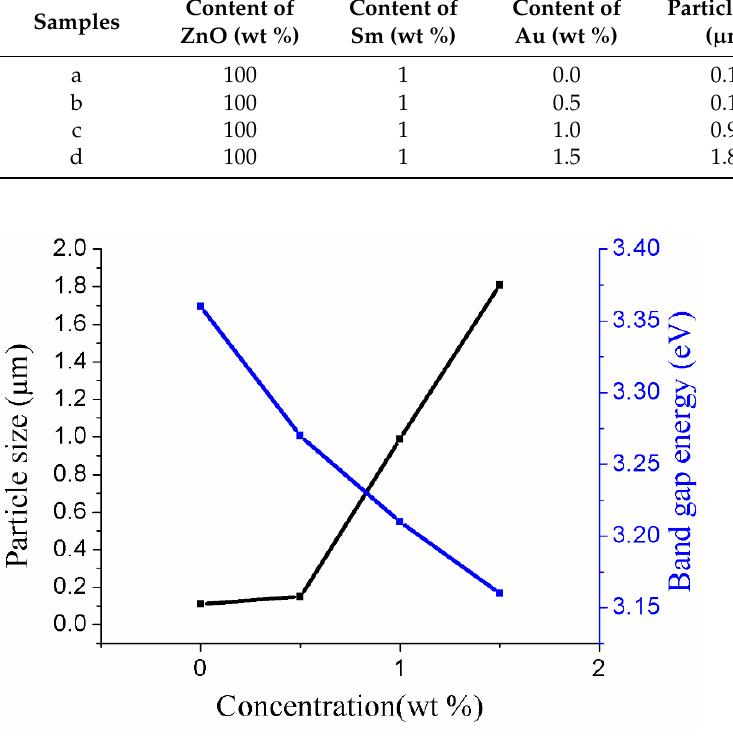
Figure 8. Particle size and bandgap energy of Au (0.0, 0.5, 1.0 and 1.5 wt%)-doped ZnO–Sm nanoparticle films. Table 2. Grain size and bandgap energy of Au (0.0, 0.5, 1.0 and 1.5 wt%)-doped ZnO–Sm nanopar- ticle films.